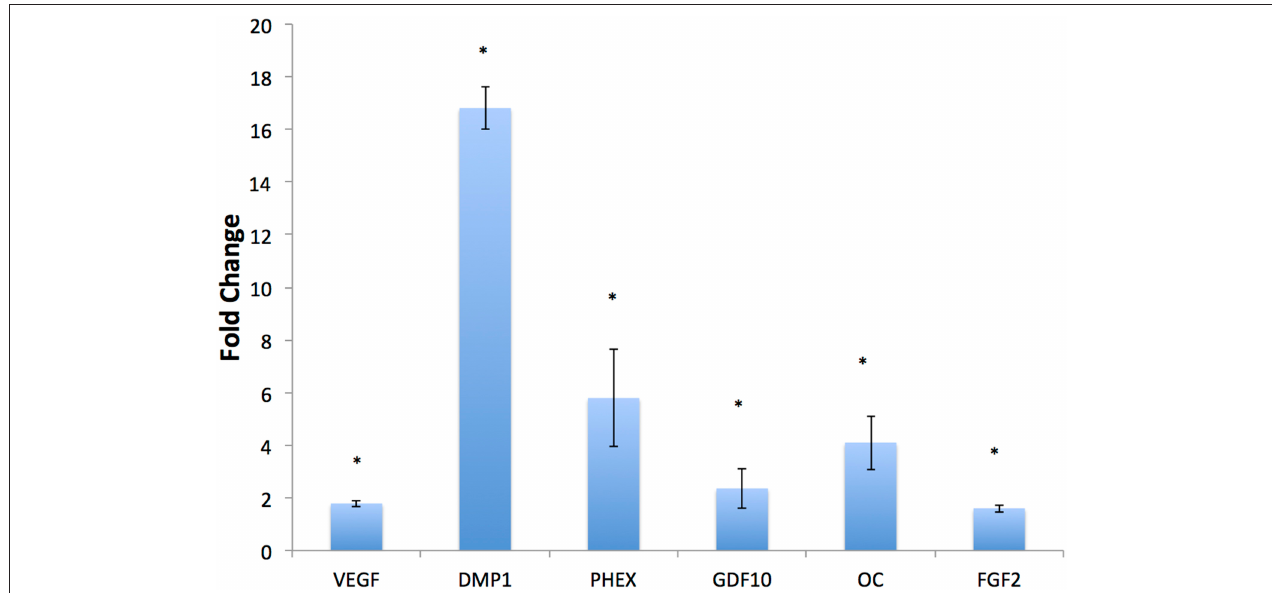
FIGURE 4 | In vitro regulation of osteogenic genes. The graph represents fold change in gene regulation of key pro-osteogenic genes and growth factors in BE-DBM with respect to control DBM. Data are represented as mean fold change obtained from quadruplicate experiments with standard deviation as error. Student’s t -test used to obtain statistical significance with respect to control. *Represents significance of P < 0.05 .